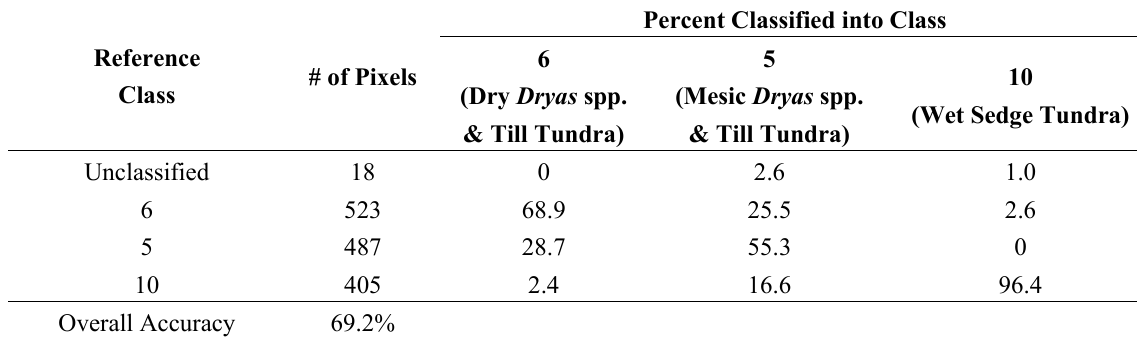
Table 4. Confusion matrix for ecological classes at